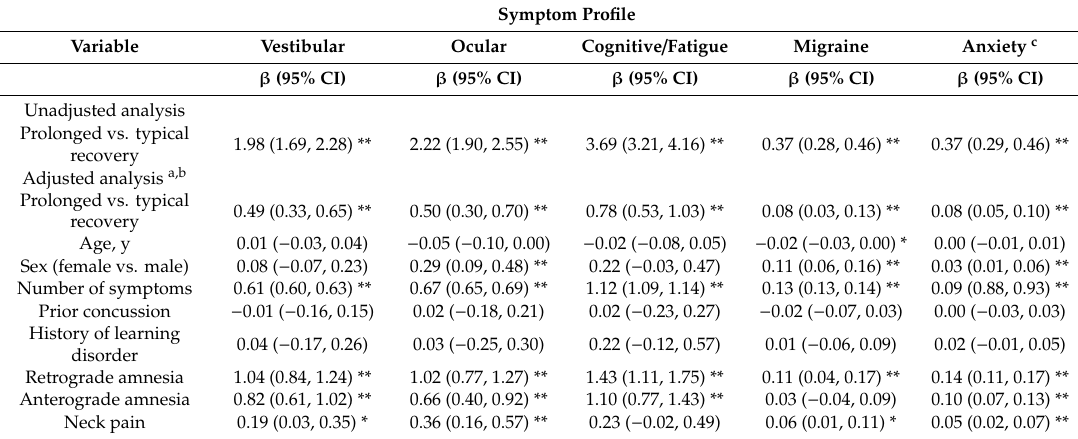
Table 4. Unadjusted and Adjusted Regression Analyses on Symptom Profiles by Recovery